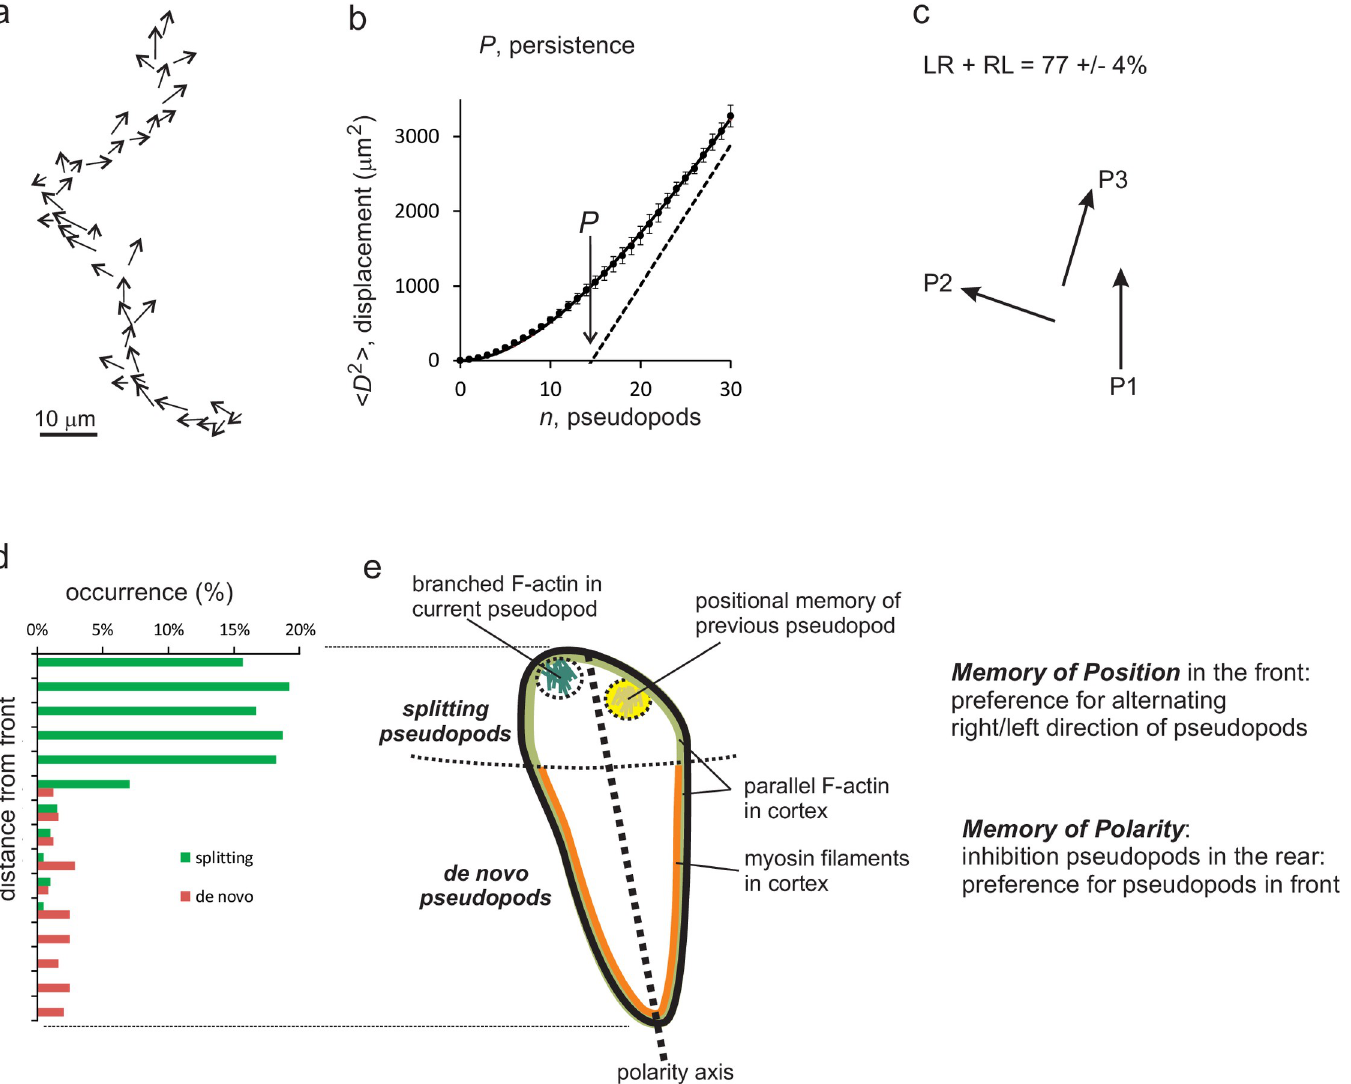
Fig 1. Dictyostelium has two types of memory. a) Path of a wild-type cell during movement in buffer for 9 minutes; the arrows indicate the pseudopods. b) The pseudopods form a trajectory of the cell. The mean square displacement ( < D 2 > ) was calculated and analyzed using Eq (1), yielding a persistence of about 15 pseudopods. c) Splitting pseudopods are frequently extending alternatingly to the right and left, leading to a zig-zag trajectories with persistence. d) Cells frequently extend splitting pseudopods at the front ~30% of the cell, and rarely de novo pseudopods from the side or the rear of the cell. This reveals that the cell has an axis of polarity leading to persistence of direction. e) Schematic of a cell showing that the source of persistence is a combination of memory of the polarity axis enhancing pseudopods to be made in somewhere in the front, and memory of the position of previous pseudopod enhancing the next pseudopod to be made at that position in the front. https://doi.org/10.1371/journal.pone.0246345.g001 three splitting pseudopods is frequently alternating to the left and right, contributing to a per- sistent zig-zag trajectory (Fig 1C). Starved wild type cells are polarized with a longitudinal axis of high pseudopod inducing activity in the front and low activity in the rear of the cell. In starved wild-type cells about 85% of the pseudopods are splitting pseudopods extending from the front ~30% area of the cell, while only ~15% of all pseudopods are de novo pseudopods that originate from the rear ~70% area of the cell. This thus shows that pseudopod formation per area is about 10-fold more active in the front than in the rear of the cell (Fig 1D). The low activity of de novo pseudopod formation in the rear is due to inhibition of pseudopod forma- tion by the acto-myosin cytoskeleton in the contractile cortex, leading to a polarized cell (Fig